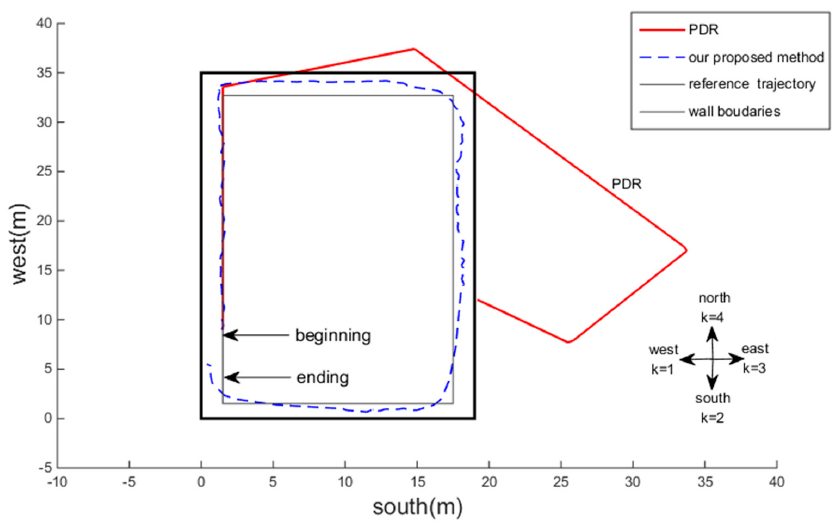
Figure 9. Trajectory comparison of the pedestrian dead reckoning (PDR) method and our proposed method.